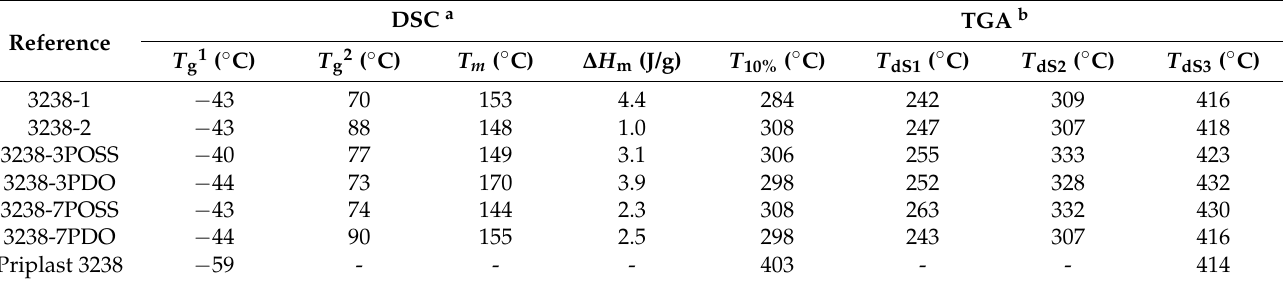
Figure 9. DSC thermogram of all of the synthesized WPUD. Glass-transition temperatures were calculated as the inflection point of the heating step scan DSC. Table 4. Thermal properties of WPUD films evaluated by DSC, TGA, and DMTA.